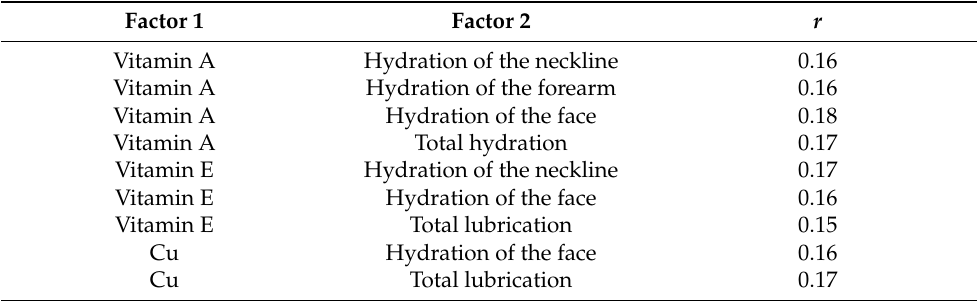
Table 7. Correlations between skin hydration, lubrication and intake of antioxidant components ( p <